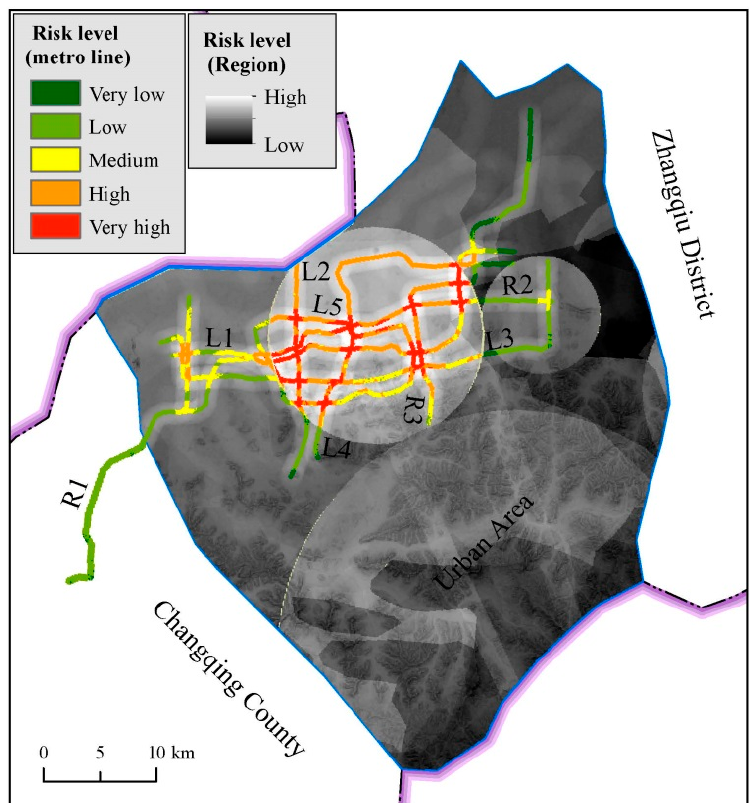
Figure 18. Risk level of metro line in urban area.